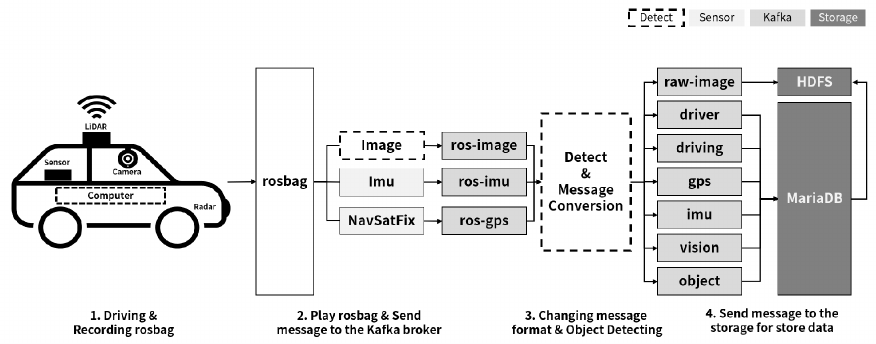
Figure 11. Autonomous vehicle data collection process.